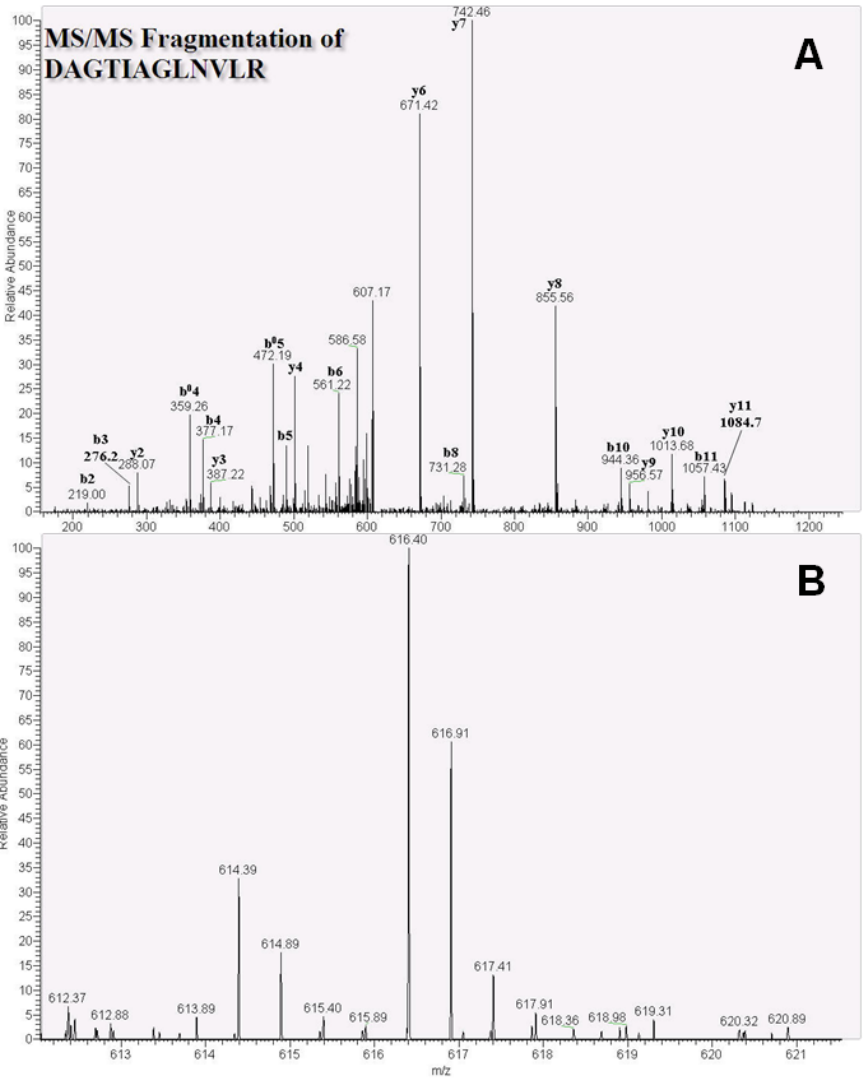
Figure 3. Nano-LC tandem MS analytic spectra of the heat shock cognate 71-kDa protein peptide DAGTIAGLNVLR in MDA-MB-231 cells. ( A ) Patterns of b- and y-ions were used to arrange the DAGTIAGLNVLR ( m / z 616.40, 2 + charge) amino acid sequence; ( B ) Formaldehyde- H 2 and formaldehyde- D 2 isotope-labeled peptides with m / z 616.40 and 614.39,